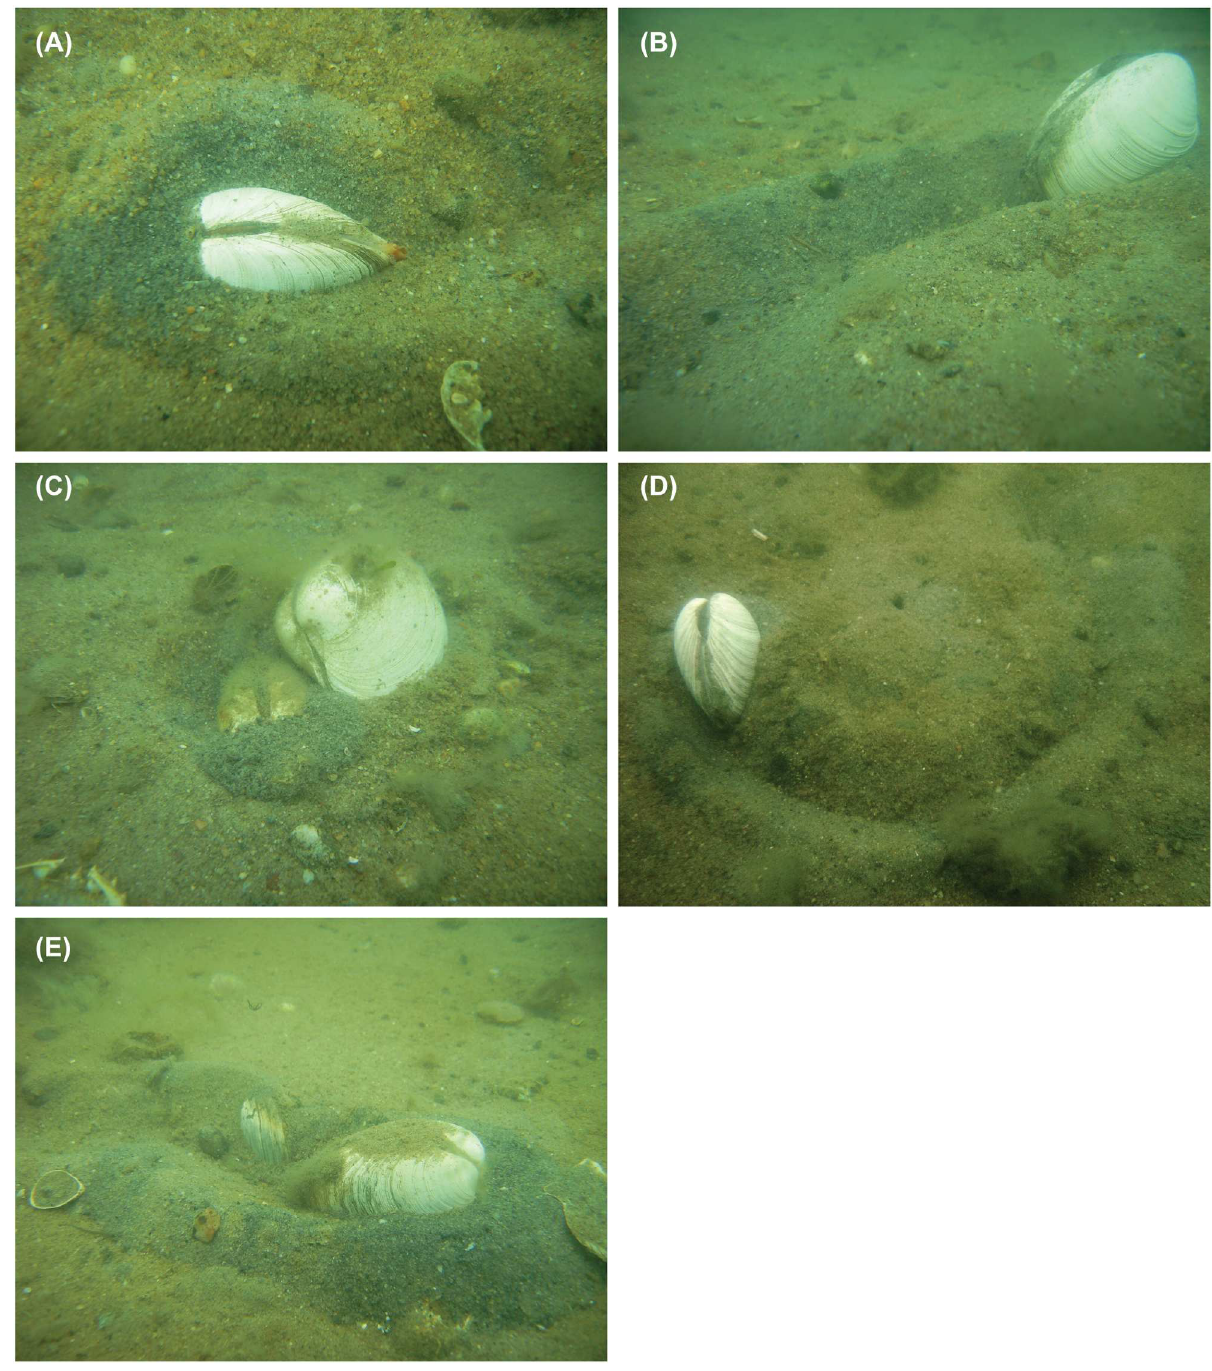
Fig 1. Hard clam, Mercenaria mercenaria , walking at East Marion, New York, USA. (A) Active walker illustratingtypical shell orientation: ligament parallelto sedimentsurface, siphonabove sedimentin furrow. (B) Active walker with freshly excavated trail (furrow). (C) Non- walkingclam lying on sedimentsurface, next to active walker. (D) Active walker at end of semi-circular trail. (E) Epibenthicclams, with posterior ends (wheresiphons are located)adjacent to one another.